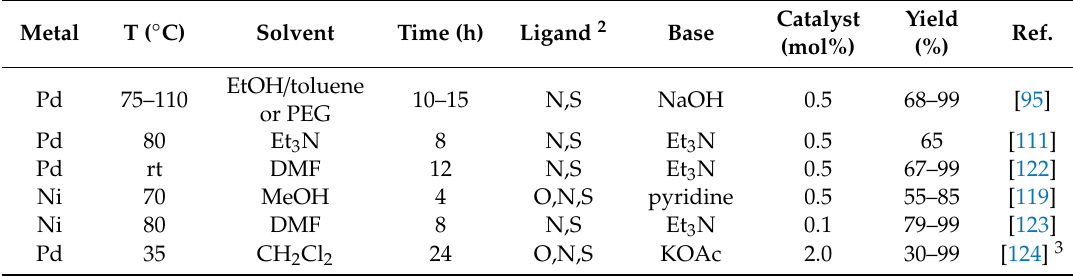
Table 3. Sonogashira reactions catalysed by thiosemicarbazone complexes: representative conditions and yields 1